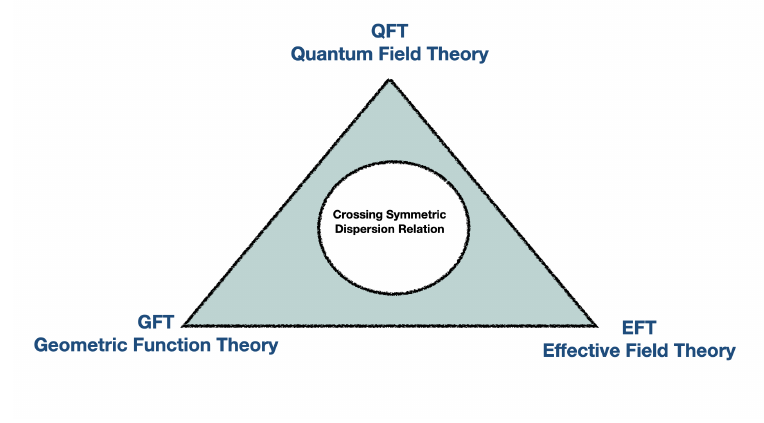
Figure 1. We examine the connections between QFT, EFT and GFT in this paper.